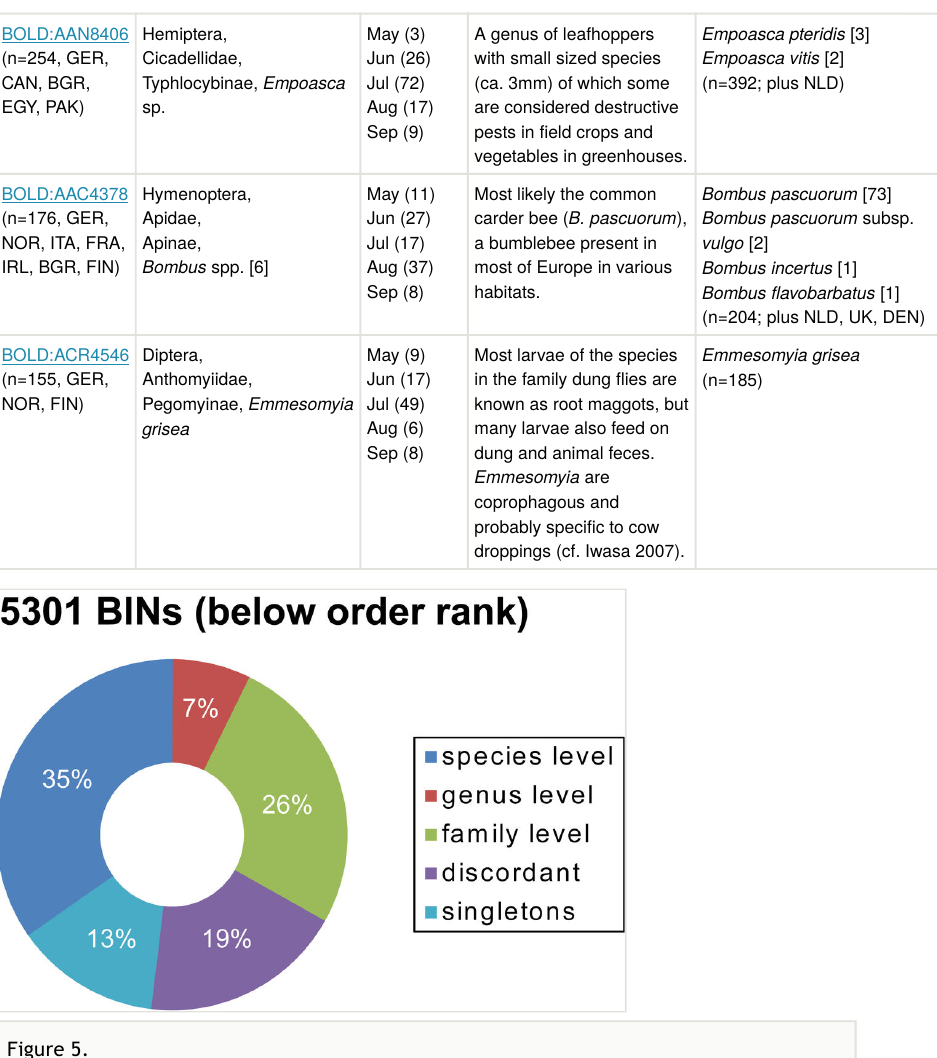
As depicted in Fig. 2, from 36% (Diptera) to 70% (Coleoptera) of the BINs belonging to species-rich orders were unambiguously assigned to a genus or species using the semi- automated BOLD annotation feature. By comparison 40% of Hymenoptera and 58% of Lepidoptera were automatically annotated with a genus or species identi fi cation.